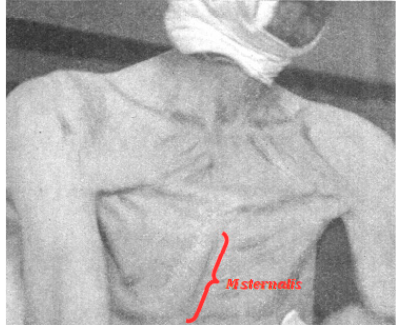
Figure 3. Image from Kirk showing tension in a unilateral, right M sternalis [36] . Image in the public